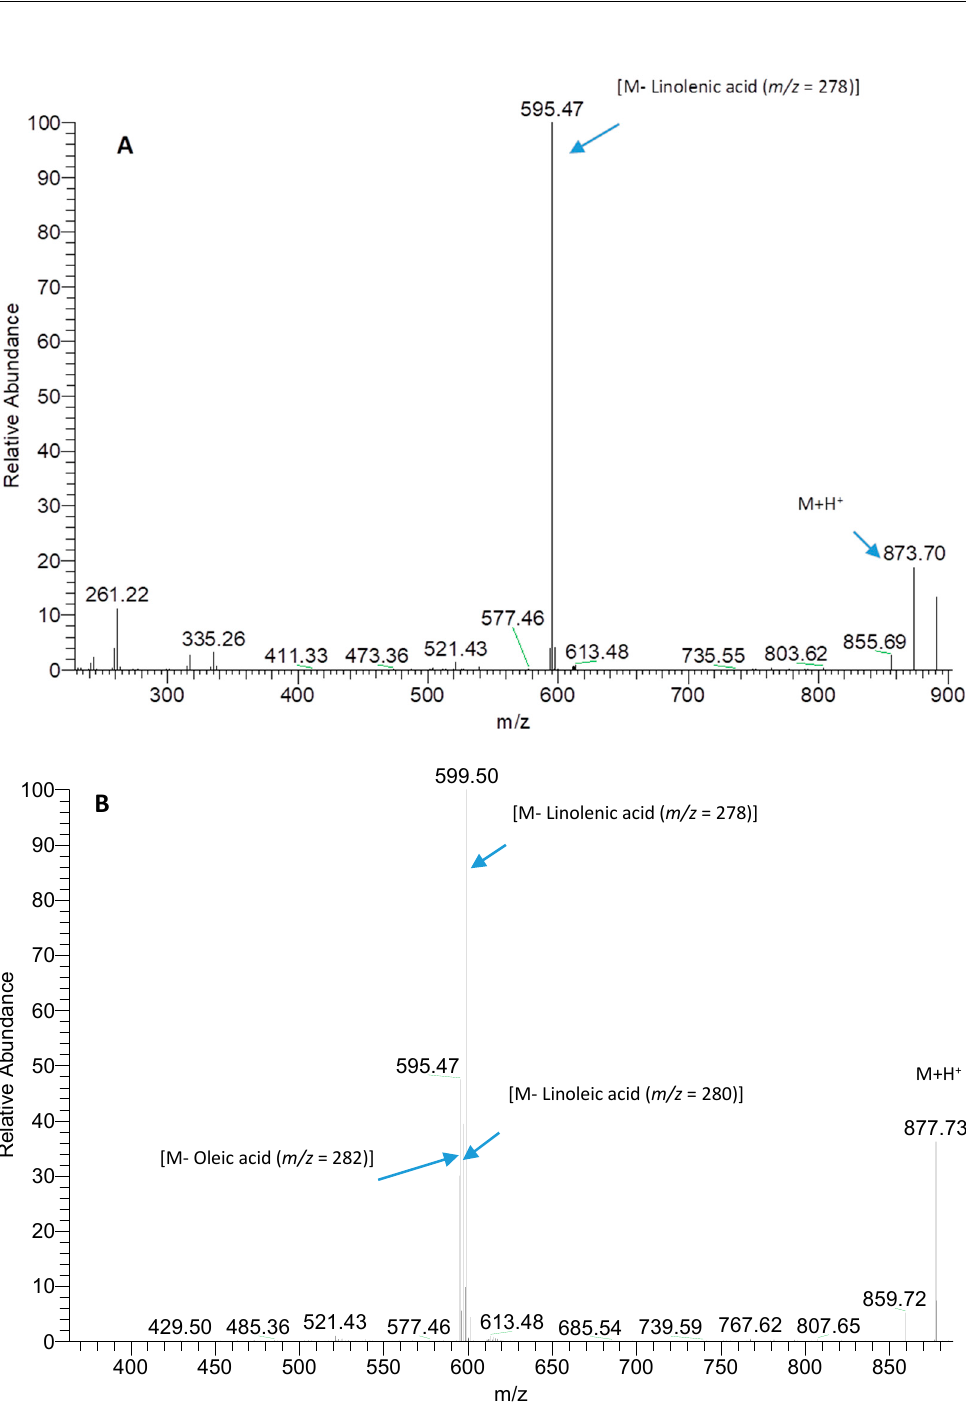
Figure 3. Mass spectrum of triglyceride (TAG) LnLnLn ( A ) and of TAG LnLO ( B ). Ln = Linolenic acid, L = Linoleic Acid, O = Oleic acid.